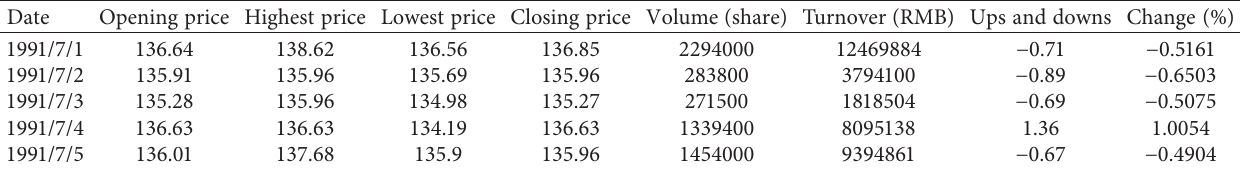
Table 1: Partial sample data.